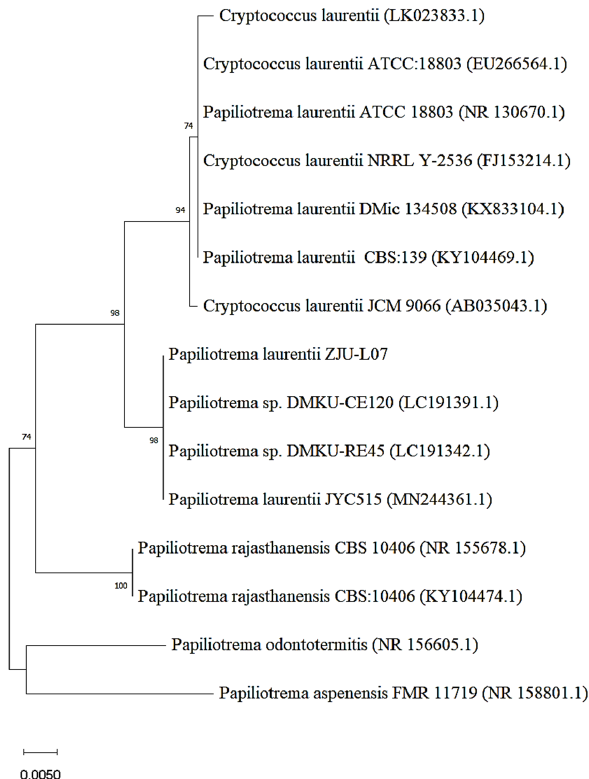
Figure 1. Neighbor-joining tree of P. laurentii ZJU-L07.